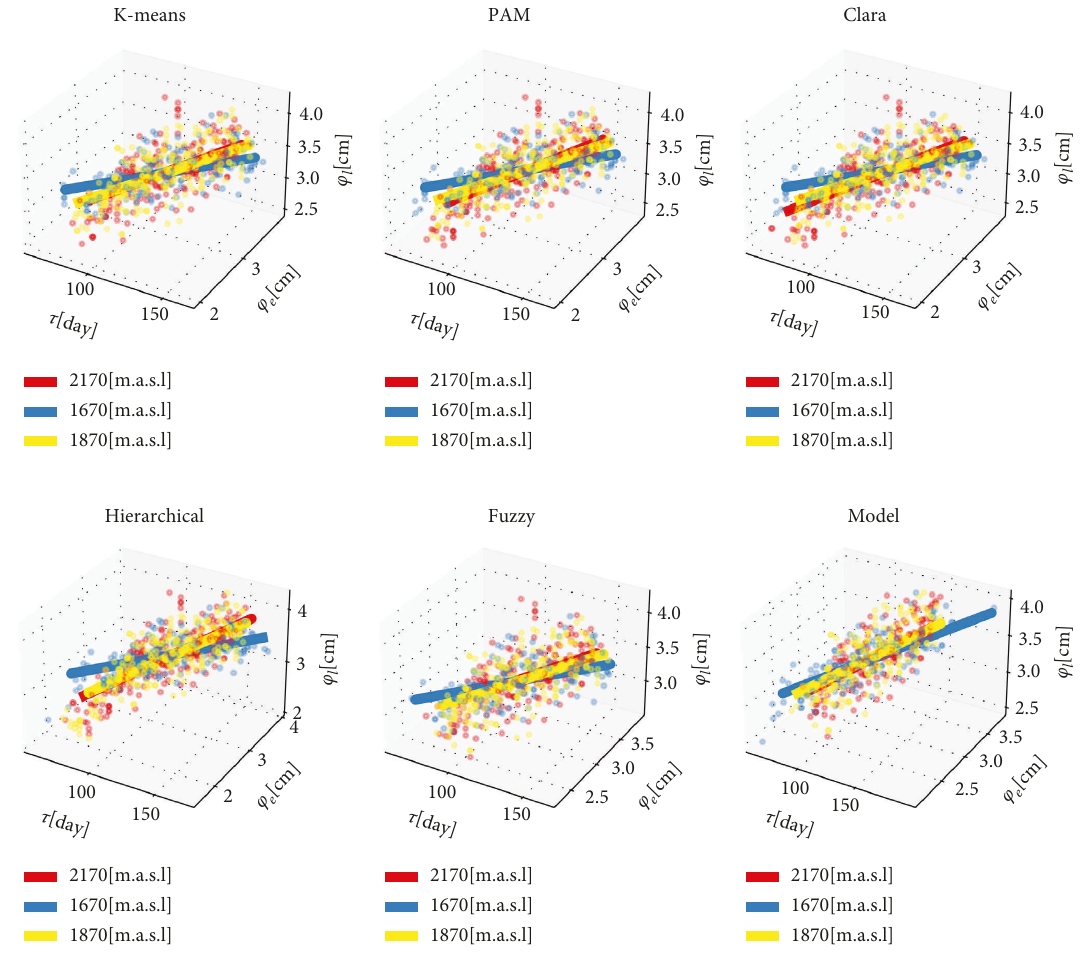
Figure 4: 3D lines adjusted by agglomeration algorithm and discriminated by Table 5: Growth rates estimated by orthogonal least squares by altitude floor.